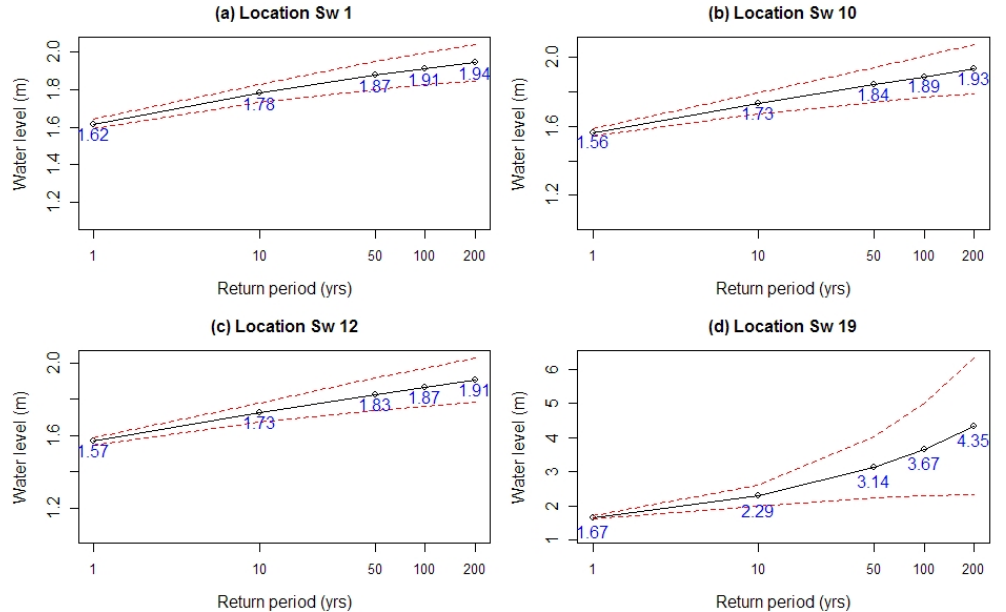
Figure 7. Results of Method 2 applied to simulated flood level data at locations Sw1, Sw10, Sw12 and Sw19. The black lines represent estimated flood levels. The red dashed lines indicate the 95% confidence